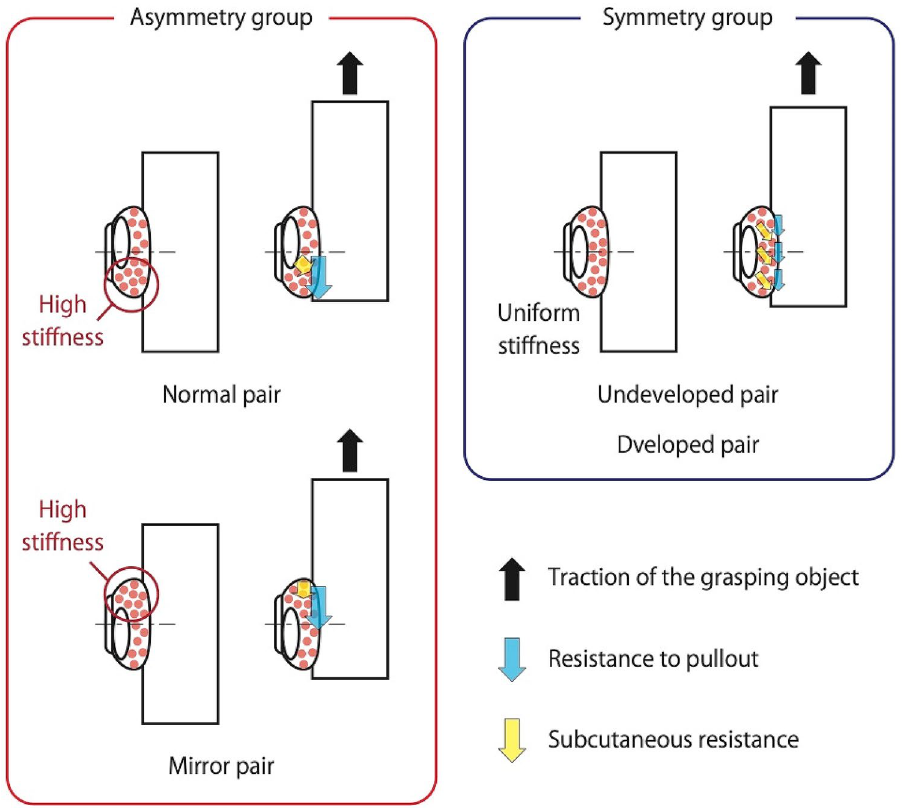
Figure 5. Consideration of the movement of the subcutaneous tissue during the withdrawal of an object. The asymmetric group is expected to be stiffer on one side, while the symmetric group is expected to be more uniformly